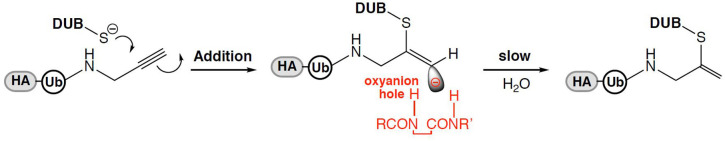
Proposed mechanism for Ub propargyl amine probes via a sterically controlled direct addition reaction with DUBs of the cysteine protease family [Abigail Schofield and Benedikt Kessler].